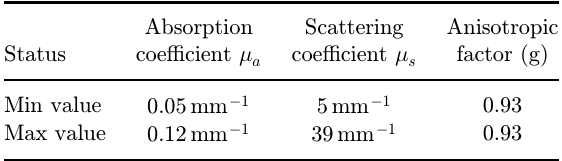
Table 1. Optical properties of porcine liver.